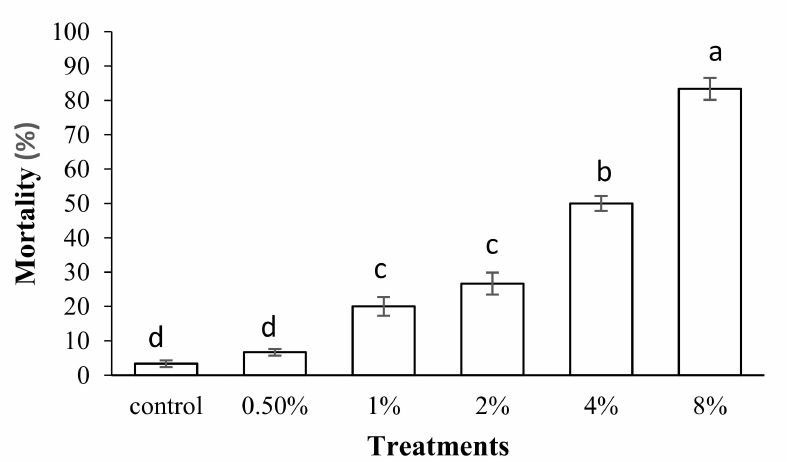
Figure 2. Effect of different concentrations of PPA on mortality percentage of Sitophilus oryzae adults. Means followed by different letters in each column are significantly different ( p < 0.05, Tukey’s